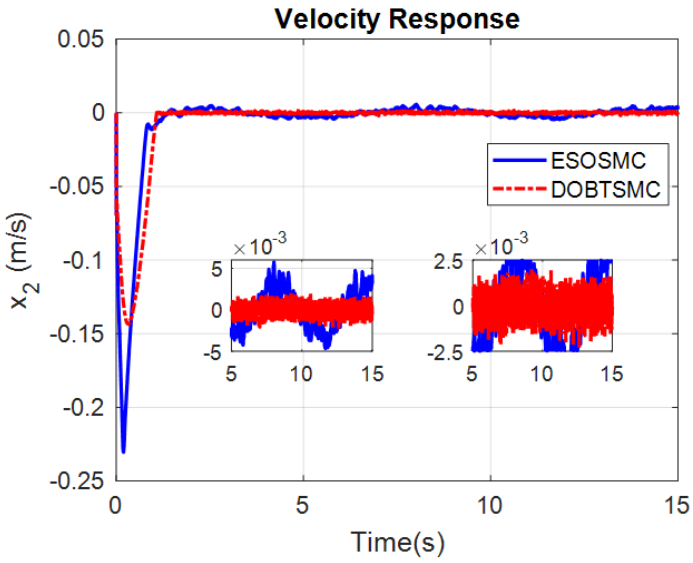
Figure 9. Velocity response of the EHA system.